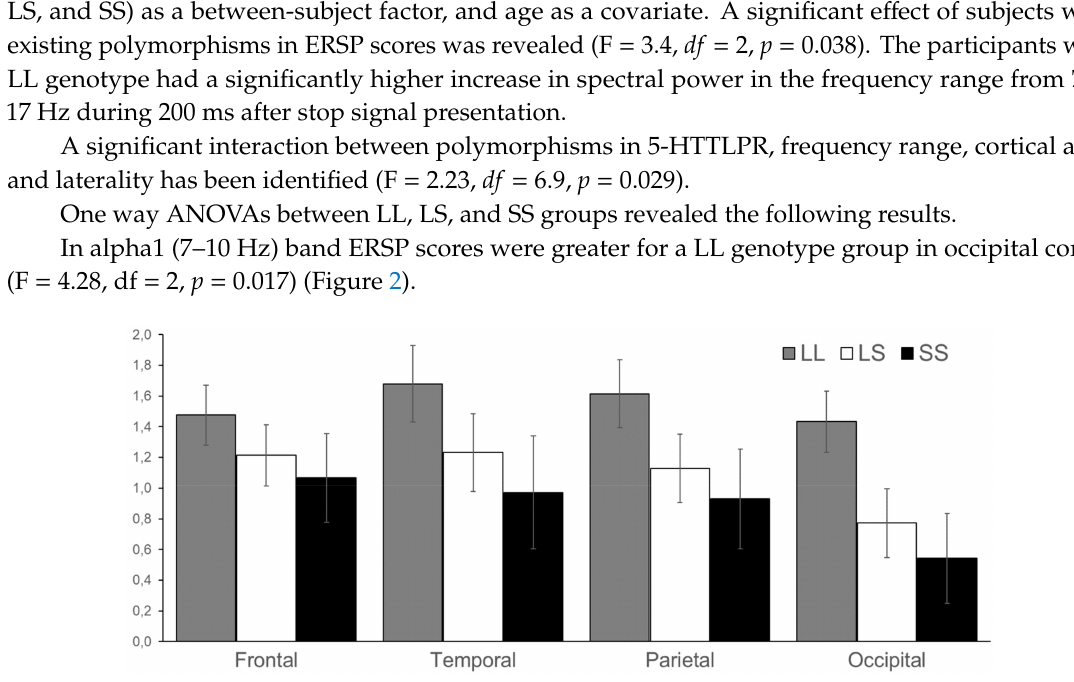
Figure 2. ERSP of alpha1 (7–10 Hz) band in frontal, temporal, parietal, and occipital cortices in LL, LS, and SS groups. Vertical lines reflect the standard